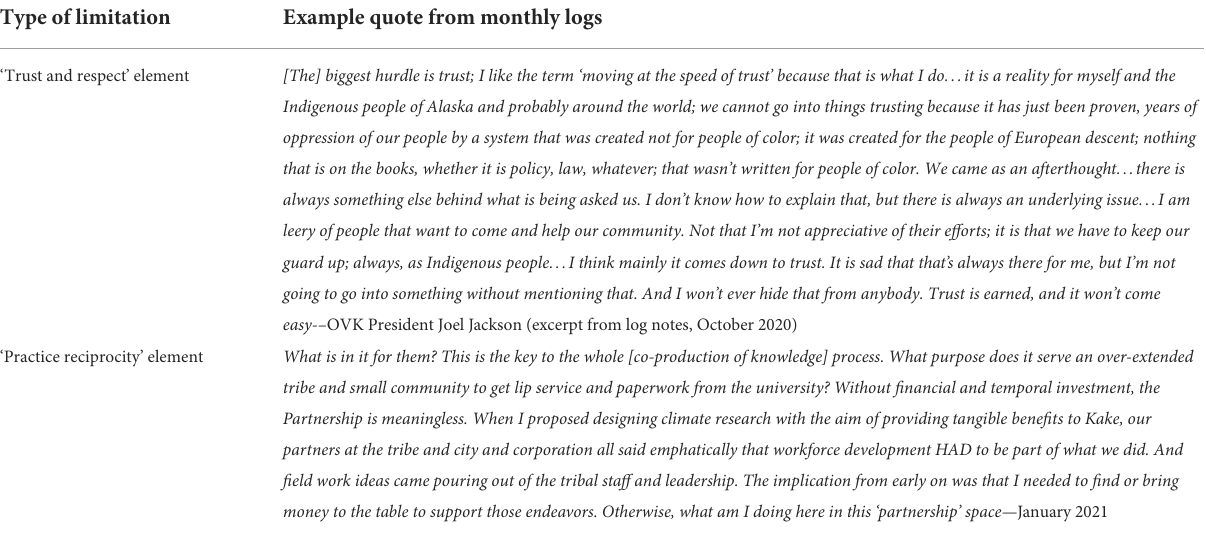
TABLE 8 Example quotes from monthly logs of elements from the Yua et al. (2022) framework that were not fully achieved (fulfilled) during this study. Limitations to fulfilling Ellam Yua co-production